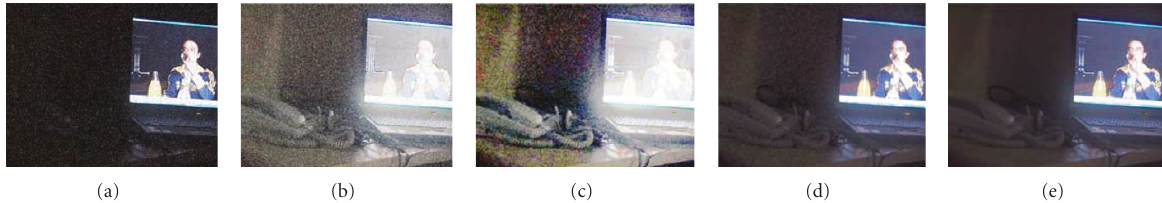
Figure 11: Results of video with under- and over-exposed regions. (a) Test video added by impulse ( p = 10%) noise. (b) Result of histogram equalization. (c) Result of P3D filter followed by histogram equalization. (d) Result of P3D filter followed by our APMF. (e) Result of our